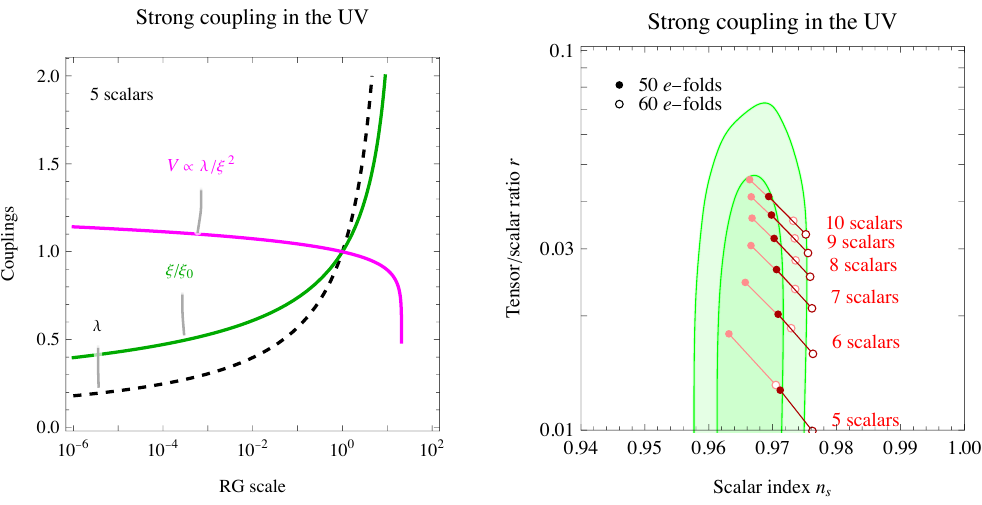
Figure 2 . Inflation with a scalar quartic that becomes non-perturbative in the UV hitting a Landau pole. Left : sample of RG running in the model of section 4.2. Right : its possible inflationary predictions, assuming small-field inflation that ends at non-perturbative λ = (4 π ) 2 (dark red) or 10 3 (light